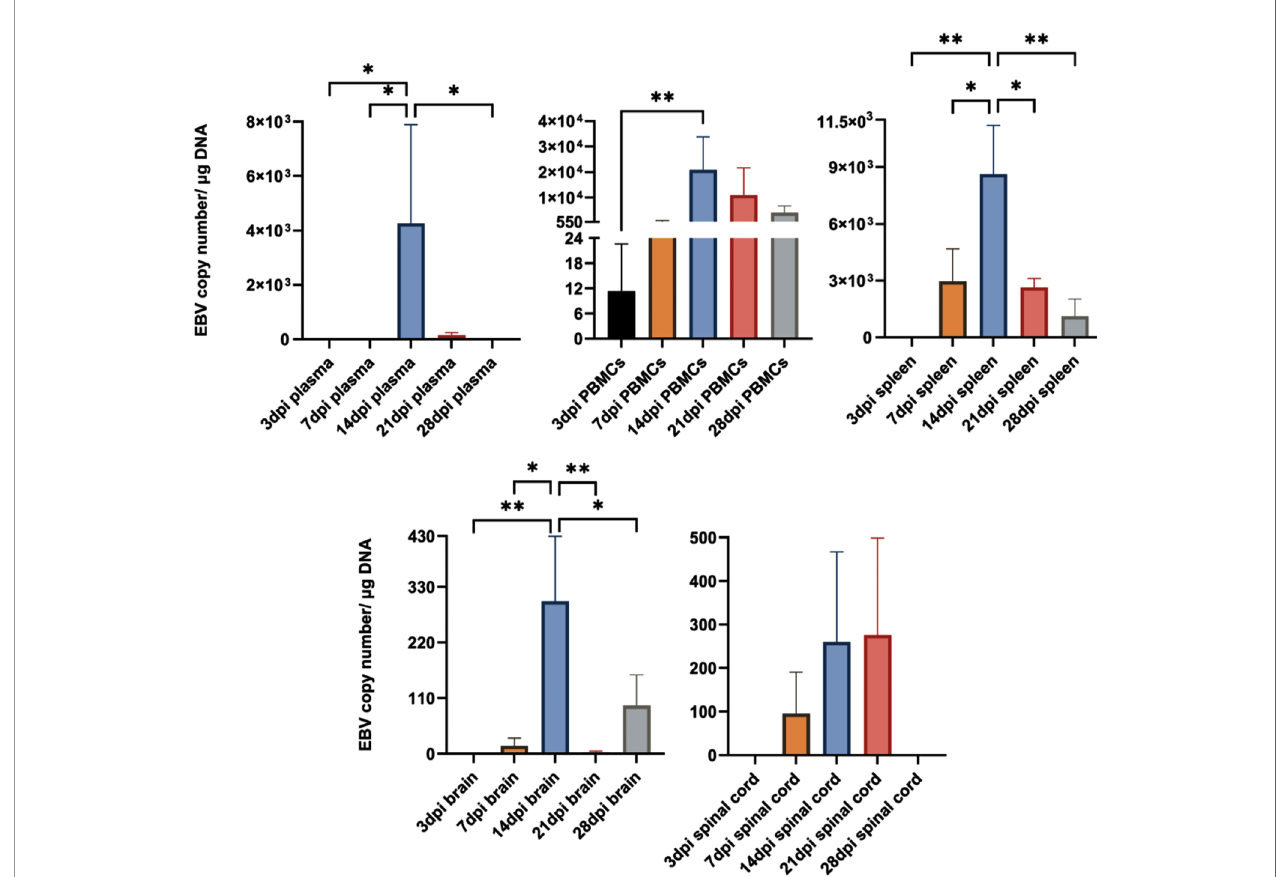
FIGURE 7 | EBV load peaks in the periphery and CNS at 14dpi. EBV copy number in plasma, PBMCs, spleen, brain and spinal cord determined by qPCR at 3, 7, 14, 21 and 28dpi ( n =3 rabbits/time-point), and displayed as mean ± SEM. One-Way ANOVA and non-parametric Kruskal-Wallis test were used to compare between groups. * p ≤ 0.05, ** p ≤ 0.01. Bars without asterisks are not signi fi cantly